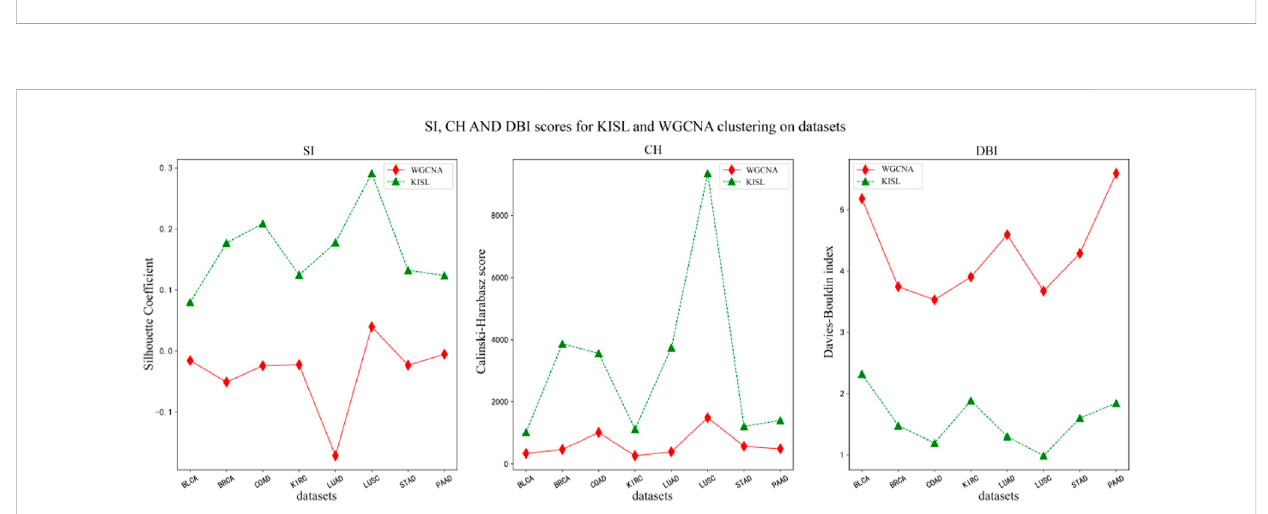
FIGURE 5 Silhouettecoef fi cient,Calinski ‒ HarabaszscoreandDavies ‒ BouldinindexfortheWGCNAandKISLalgorithms.Theevaluationvalueobtainedbythe KISL algorithm was the best in all the